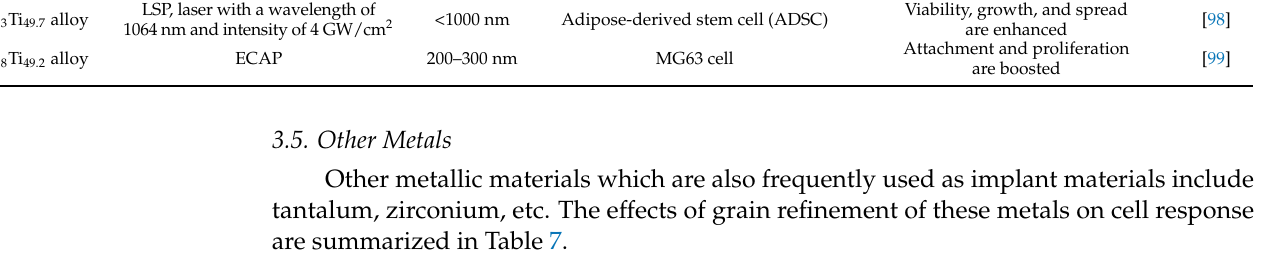
Table 7. Cell response after surface/bulk grain